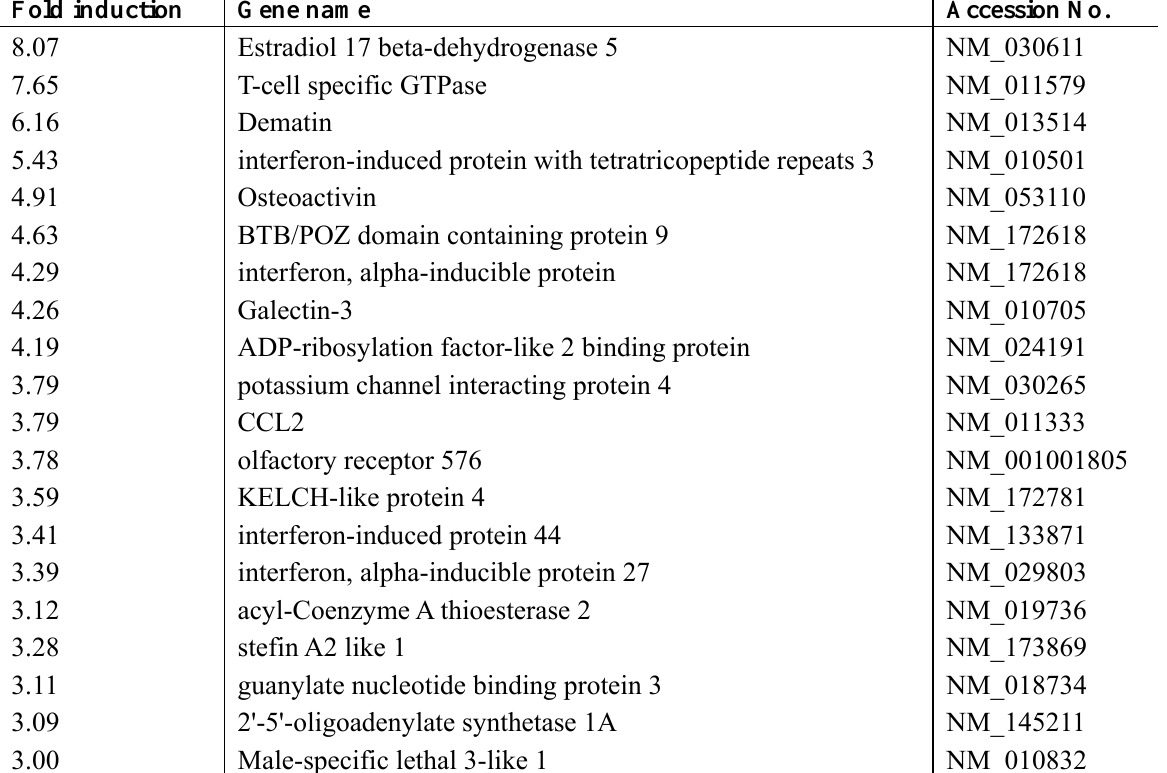
Table 1. Top 20 up-regulated genes in the VASH1 stable transfectant.